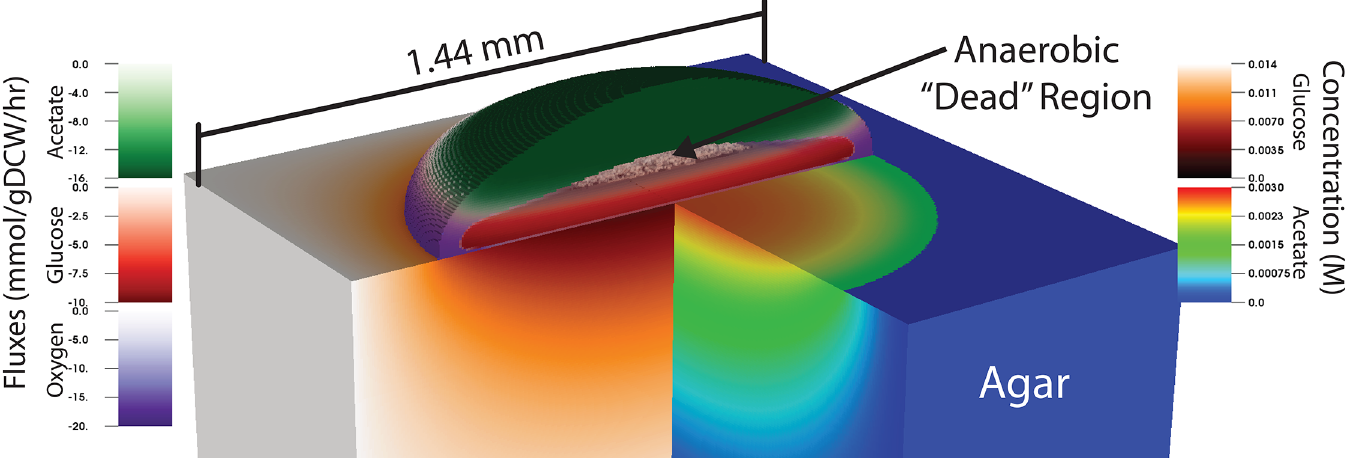
Fig 1. Metabolic crossfeeding in E. coli . A visualizationof a 3DdFBA simulationof metaboliccooperativity in E. coli K-12 MG1655 growingon a 2.5% glucose agar substrate (described previously[16]). The image depicts metaboliccooperativity betweenaerobic (purple)and anaerobic(red) glucose utilizing cells, which generateacetate that is utilized aerobically by glucosestarved cells (green). Completesubstrate utilization at the top and bottom of the colony create an anoxic dead zone containing essentiallydormant cells. Color bars on the left represent metabolicfluxes of the indicatedmetabolites while those on the right indicate concentrations of glucoseand acetate insidethe agar. The image was visualizedusing the VisIt visualizationsoftware (as describedin the Methods) with a custom pluginwritten to support 3DdFBA simulation.